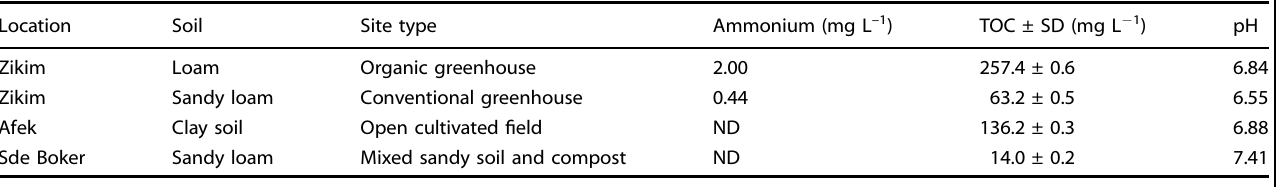
Table 1. Initial total organic carbon (TOC) and ammonium concentrations in the collected soil pore